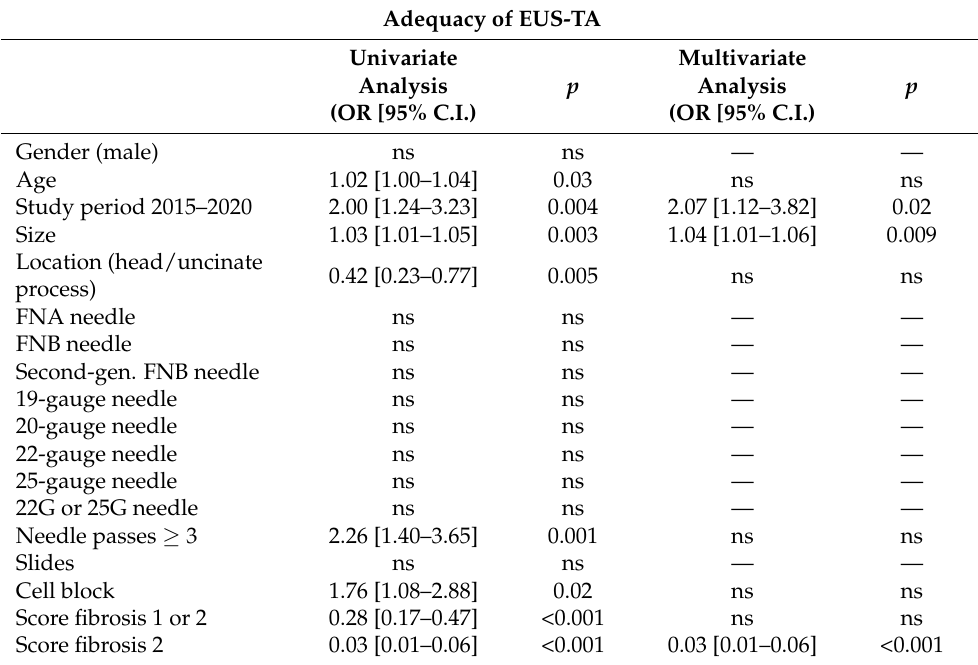
Table 6. Variables related to good adequacy (score of 2 or 3) of EUS-guided tissue acquisition